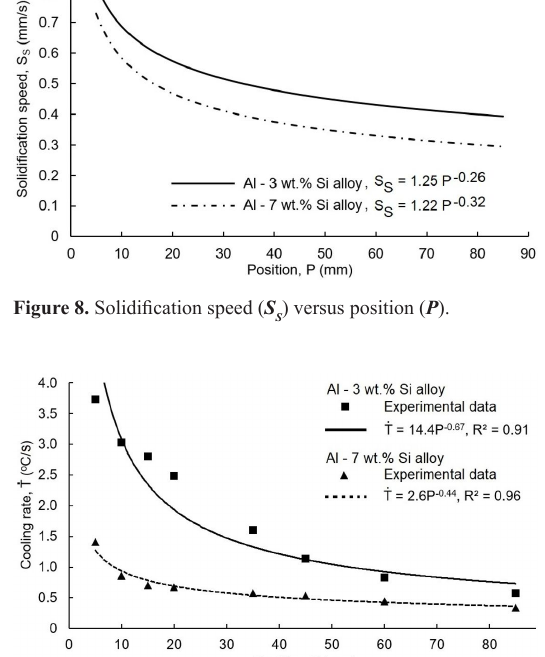
Figure 7. Liquidus temperature position and solidification speed ( S versus time: a) Al - 3 wt. % Si alloy, and b) Al - 7 wt. % Si alloy.